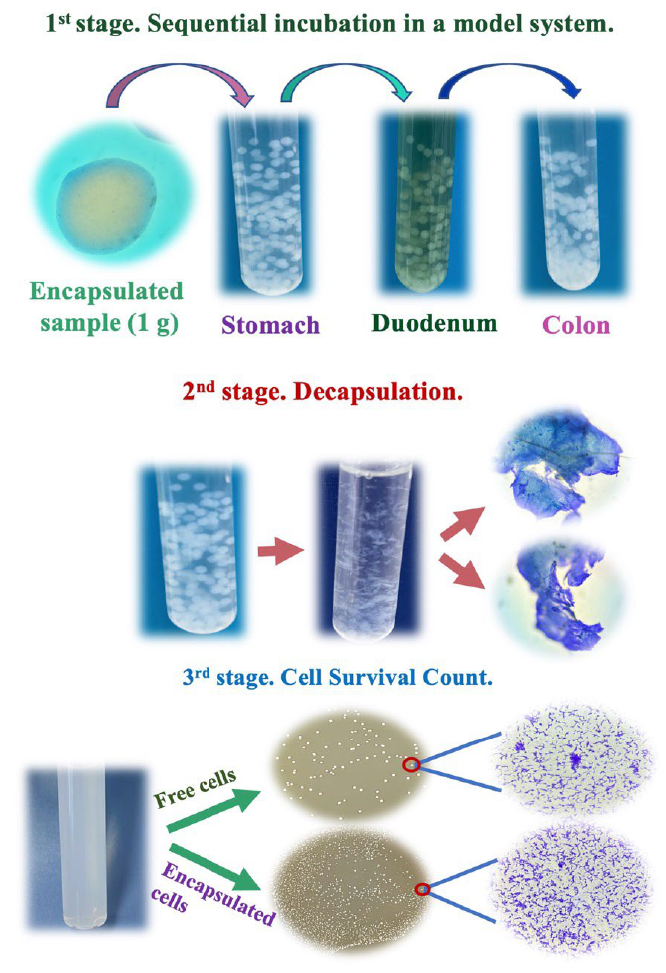
Figure 4. Experimental design of the simulating gastrointestinal (GI) tract.